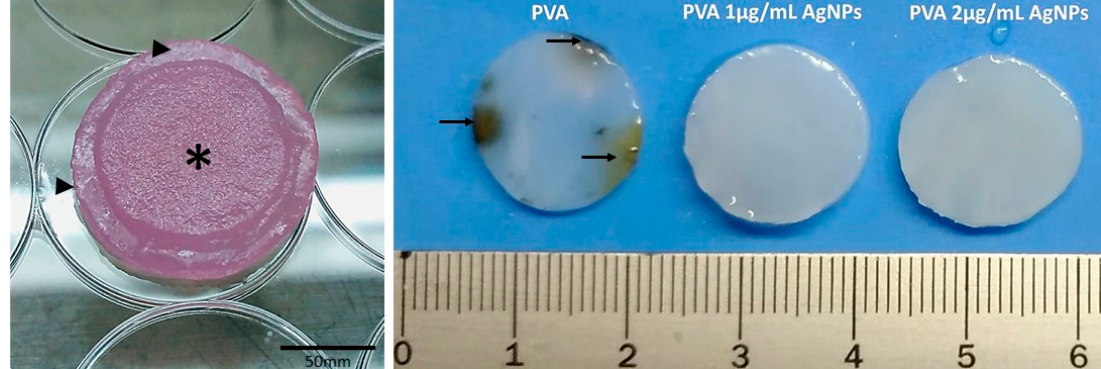
Figure 1. Left image shows macroscopic observations of the bilaminar device of PVA-AgNP (arrowheads) associated with the col-HA membrane (asterisk). The pink presentation is due to the culture medium absorption prior to the in vitro assays. Right image indicates the presence of PVA containing or not AgNP. After a few days under normal atmosphere, the free-AgNP samples presented a distinct fungal growth (arrows).